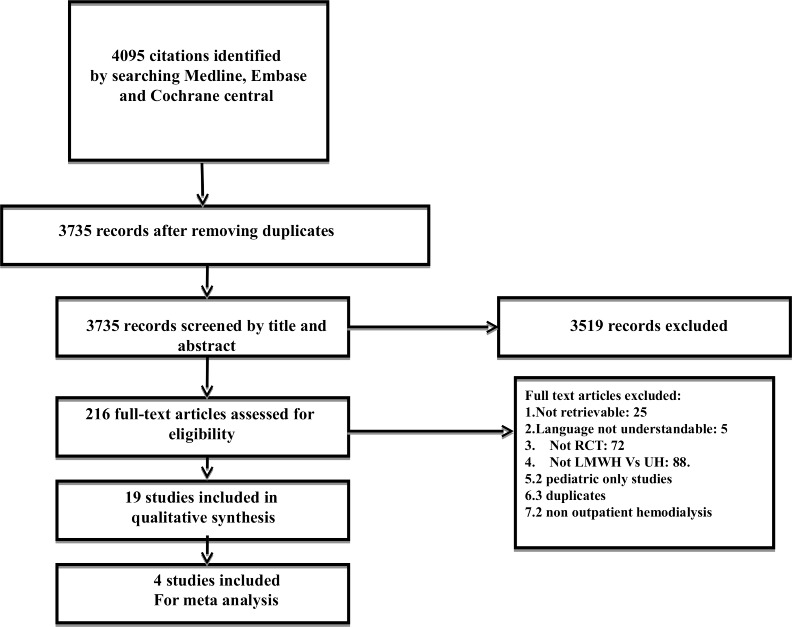
Article flow diagram.Details the process of study inclusion into the review